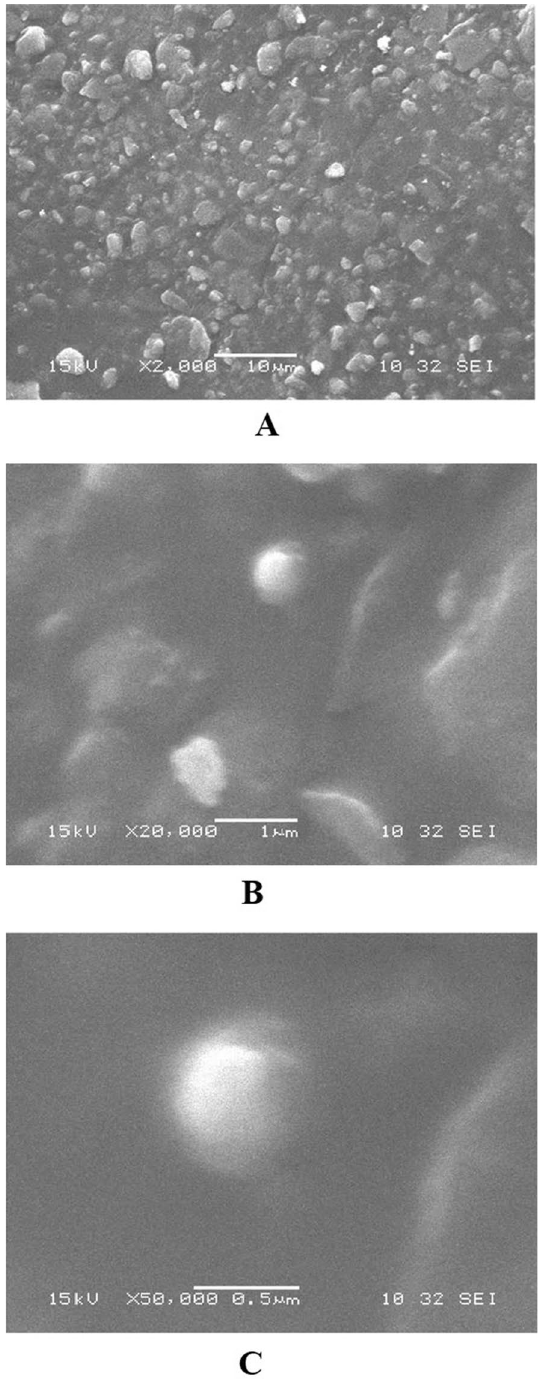
Figure 4. Scanning electron micrograph of dextran sulfate sodium (DSS) nanoparticles of batch 3. ( A ) DSS nanoparticle at × 2000 magnification. ( B ) DSS nanoparticles at × 10,000 magnification. ( C ) DSS nanoparticles at × 50,000